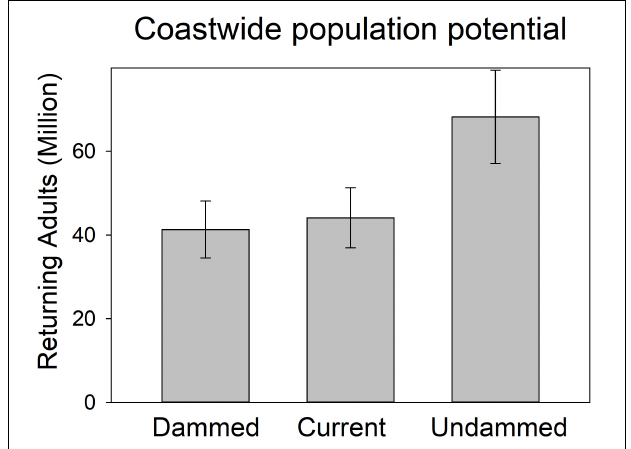
FIGURE 8 | Coast-wide spawning potential of American shad under the no passage (“Dammed”), status quo (“Current”), and no dam (“Undammed”) passage scenarios. Boxes indicate 25th to 75th interquartile range and whiskers indicate 95% CI.